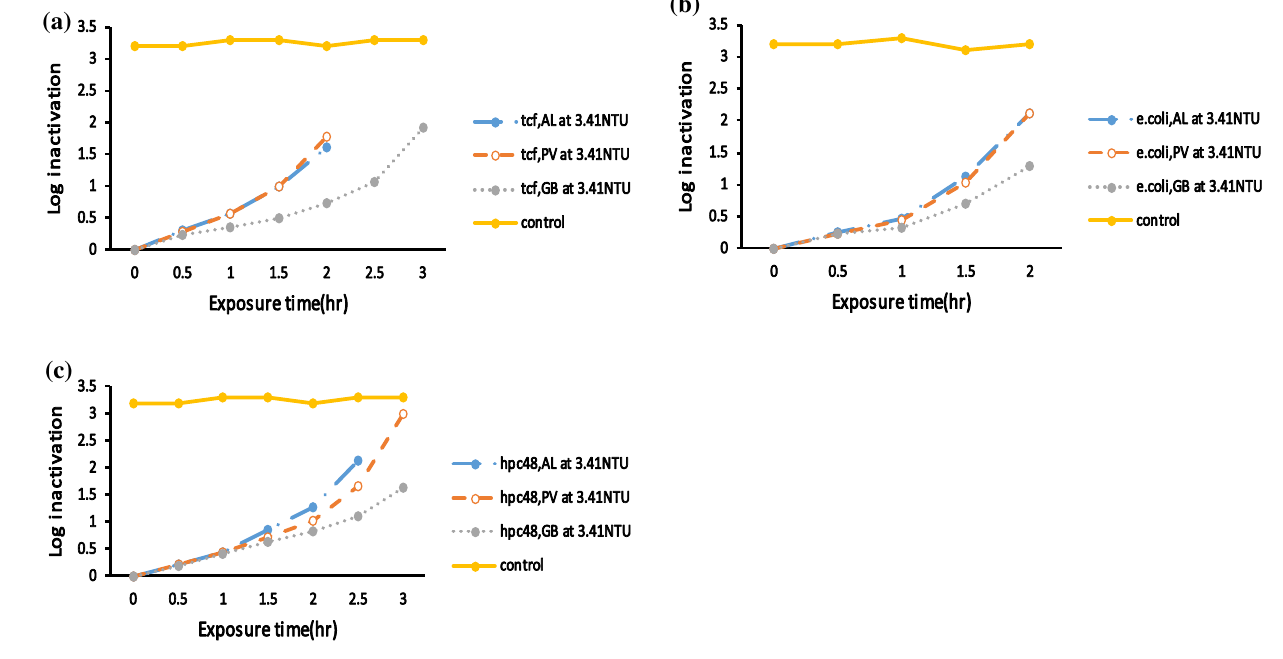
Fig. 4 Comparison of microbial inactivation between concentrators at 3.41 NTU turbidity level. a Comparison between concentrators for total coliform counts inactivation; b comparison between concentra-